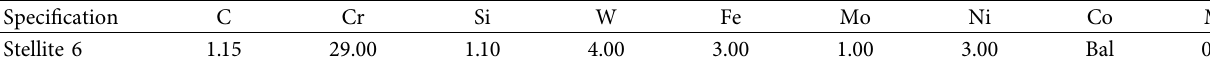
Table 2: Chemical composition of Stellite 6 powder (mass fraction, %).